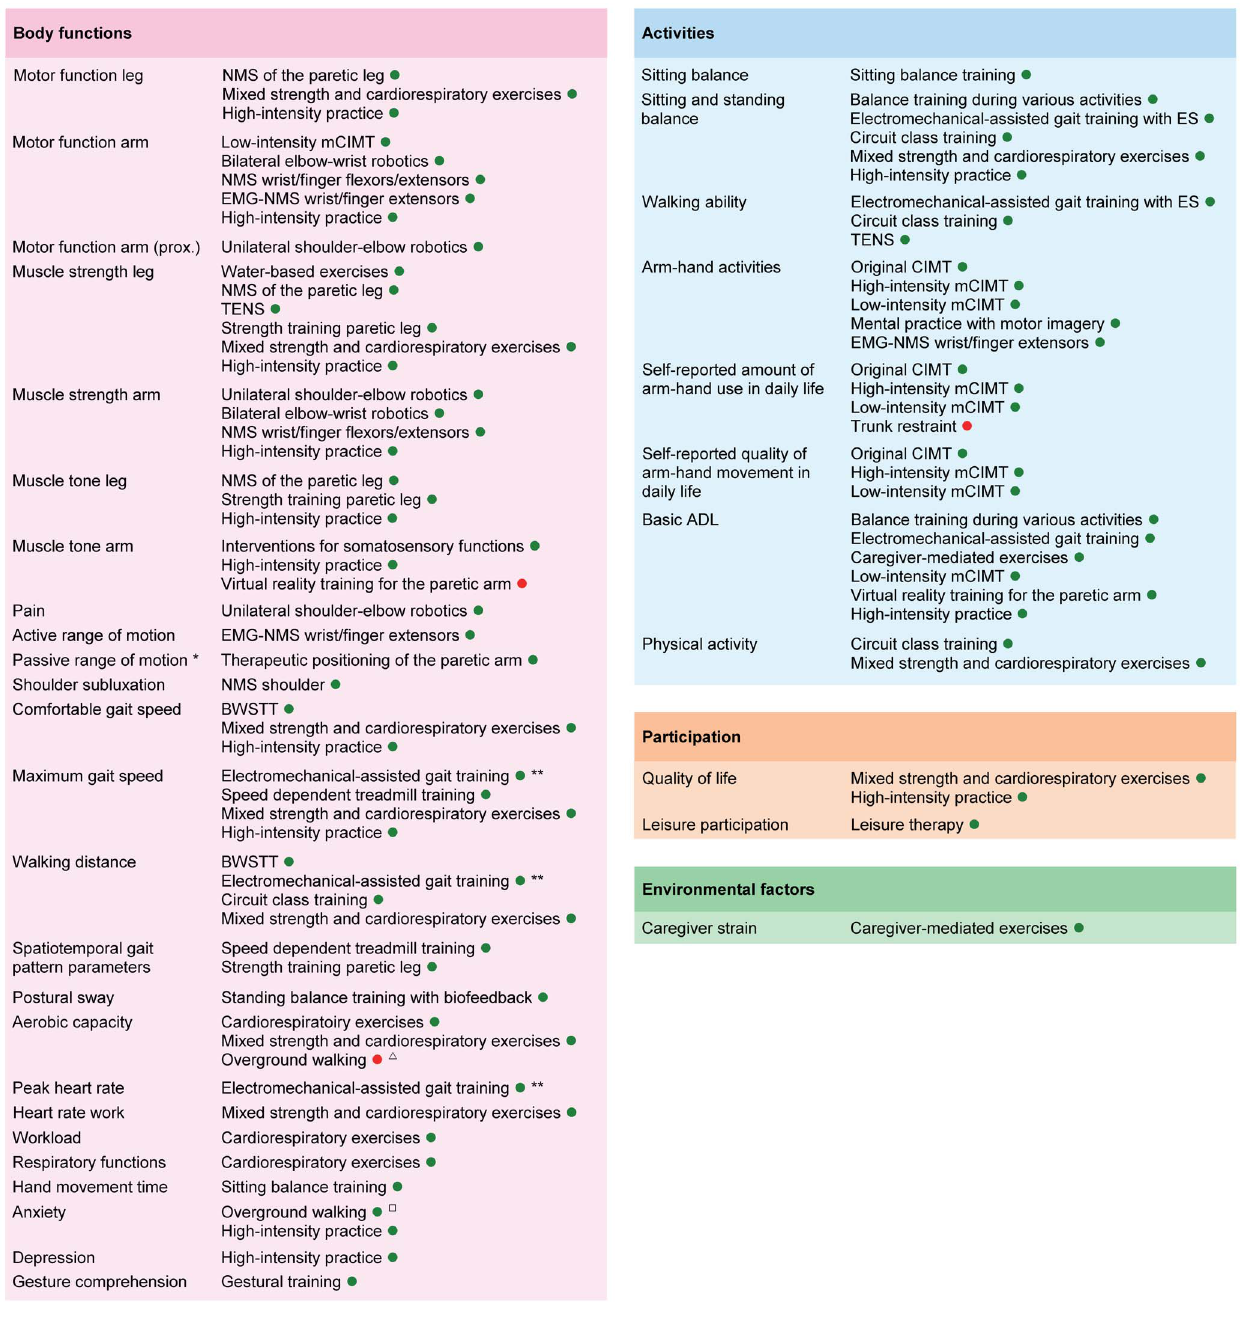
Figure 8. Overview of outcomes for which interventions are available with significant summarized effects. Legend: A green point indicates that the intervention has a significant positive effect on the outcome, while a red point indicates that the intervention has a significant negative effect on the outcome; *, shoulder external rotation; **, dependent walking patients in the early rehabilitation phase; n , dependent walking patients when compared to electromechanical-assisted gait training or BWSTT; % , independent walking patients; BWSTT, Body-weight supported treadmill training; CIMT, Constraint-induced movement therapy; EMG-NMS, Electromyography-triggered neuromuscular stimulation; ES, Electrostimulation; mCIMT, modified Constraint-induced movement therapy; NMS, Neuromuscular stimulation; prox., Proximal; TENS, Transcutaneous electrical nerve stimulation.